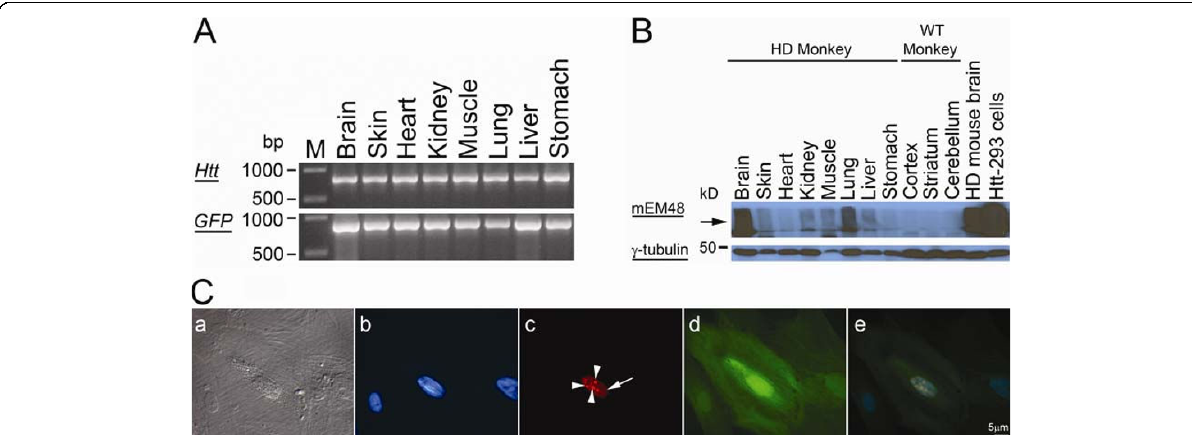
Figure 1 Characterization of HD monkey and HD monkey skin fibroblasts . (A) The presence of transgenes “ mutant htt and GFP “ in brain and peripheral tissues of HD monkey was confirmed by PCR analysis using primer sets specifically for mutant htt (top panel) and for the GFP gene (bottom panel). (B) Expression of the transgenic mutant HTT was confirmed by Western blot analysis in brain and peripheral tissues using mEM48 (top panel). Immunoblot revealed high-molecular-mass oligomeric HTT (arrow). The blot was also probed with an antibody to g -tubulin as an internal control (bottom panel)., Wild-type (WT) non-transgenic monkey. (C) Immunostaining of primary cultured skin fibroblast of transgenic HD monkey using mEM48 demonstrated that transgenic mutant htt was distributed in the nuclei (arrow; C-c) and intranuclear inclusions (arrowheads; C-c) were also revealed. Expression of GFP was also revealed by epifluorescent microscopy (d). (C-a) transmission light image; (C-b) Hoechst DNA staining; (C-c) mEM48 staining; (C-d) epifluorescent light image of GFP; (C-e) overlay image. Scale bar = 5 μ